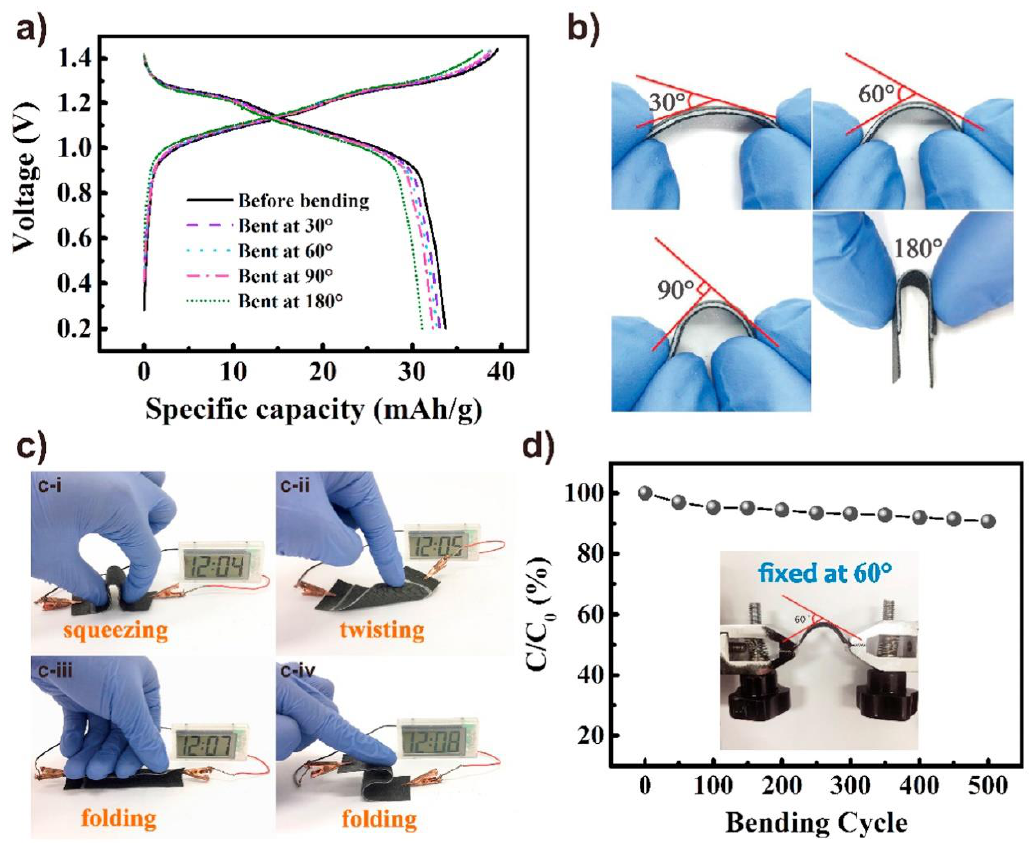
Figure 26. Electrochemical performance of the flexible lithium ion battery under various deformation conditions. ( a ) Galvanostatic charge/discharge under different bending angles. ( b ) Demonstration of bending at different angles. ( c ) Powering an electronic watch when being ( c-i ) squeezed, ( c-ii ) twisted, and ( c-iii , c-iv ) folded. ( d ) Capacity retention of the battery after 500 bending cycles at a bending angle of 60° (C 0 and C correspond to the specific capacity before and after bending, respectively) [205].